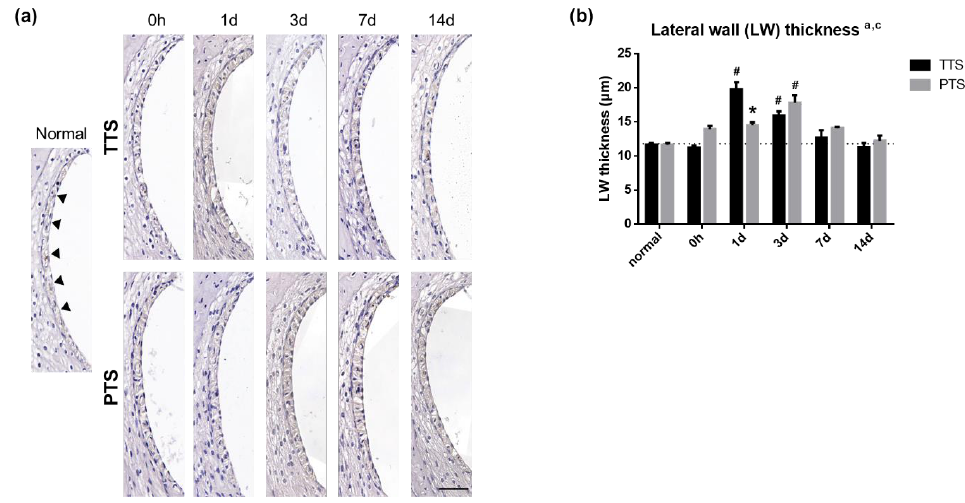
Figure 6. Thickness of lateral wall after noise exposure. ( a ) Hematoxylin staining was performed on inner ear section at each time point. ( b ) After noise trauma, the stria vascularis thickness was significantly increased in TTS and PTS groups. Scale bars represent 50 μm. a, main effect of day, p < 0.05 and c, interaction, p < 0.05. All graphs represent mean ± S.E.M. Two-way ANOVA, Tukey’s multiple comparisons test. Asterisk denotes difference from TTS per day, p < 0.05 and pound symbols (#) denote differences from matching normal (pre) controls, p < 0.05. n = 3.